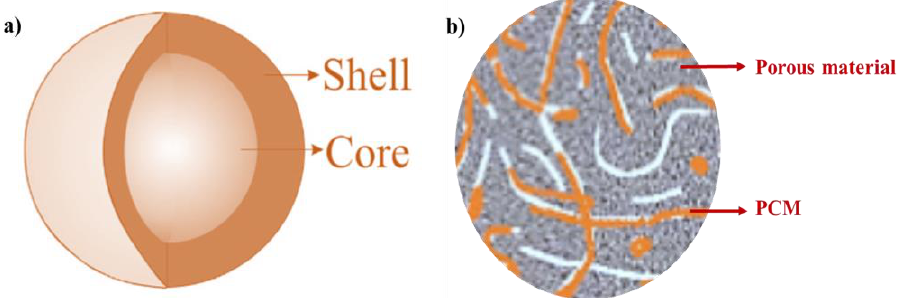
Figure 3. Architectures of ( a ) a capsule of core-shell encapsulated PCM and ( b ) shape-stabilized PCMs are depicted.